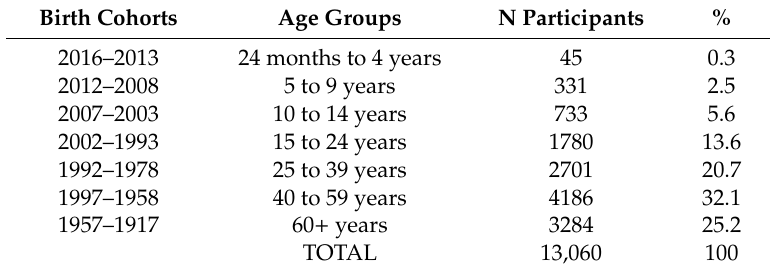
Table 1. Characteristics of study participants: age (calculated as of 31 December 2016), birth cohort, and proportion of participants by birth cohort. Birth Cohorts